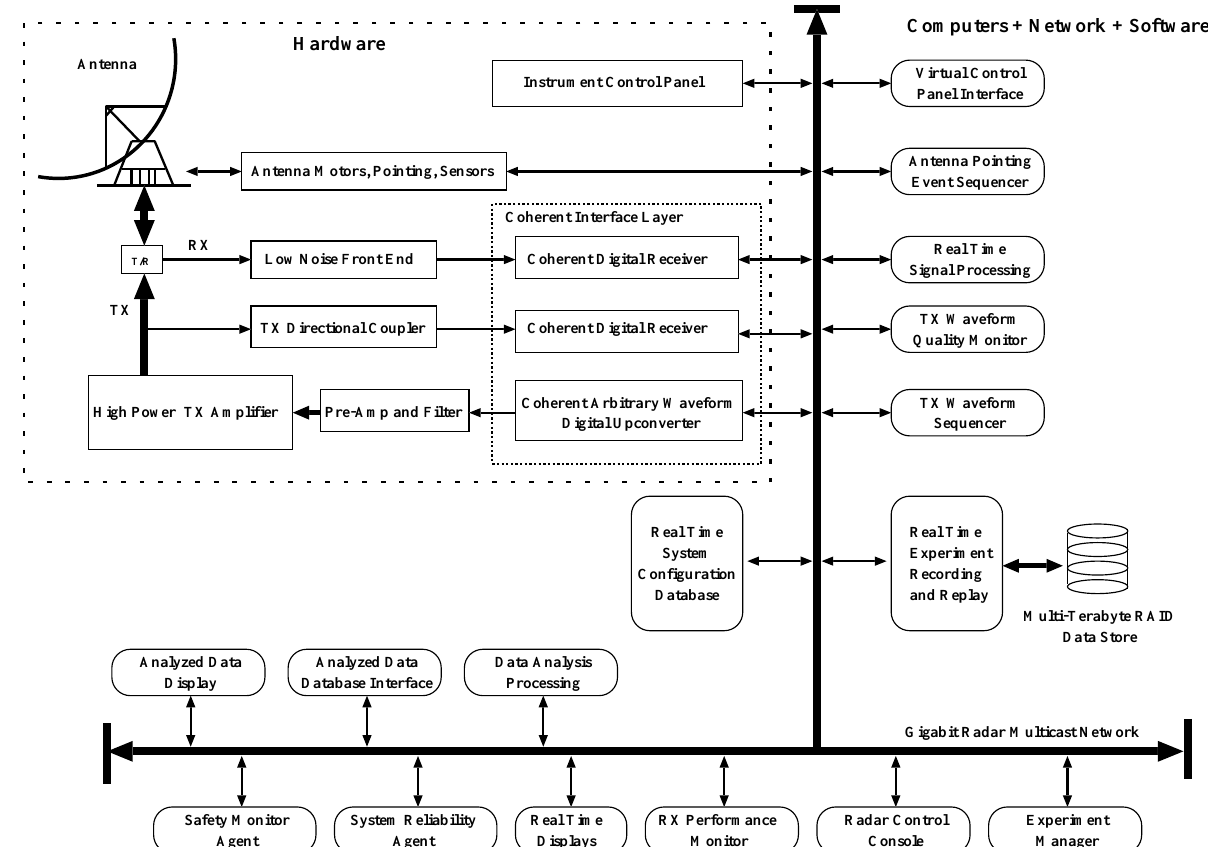
Fig. 1. A simplified diagram of a generic Software Radar architecture. Analog elements are interfaced directly to a high speed multicast data network which provides the information transport necessary for real-time data processing. Multicasting allows many different software agents on a variety of computing platforms to share access to system data. High speed data recorders allow storage of command, status, signals, and radar output